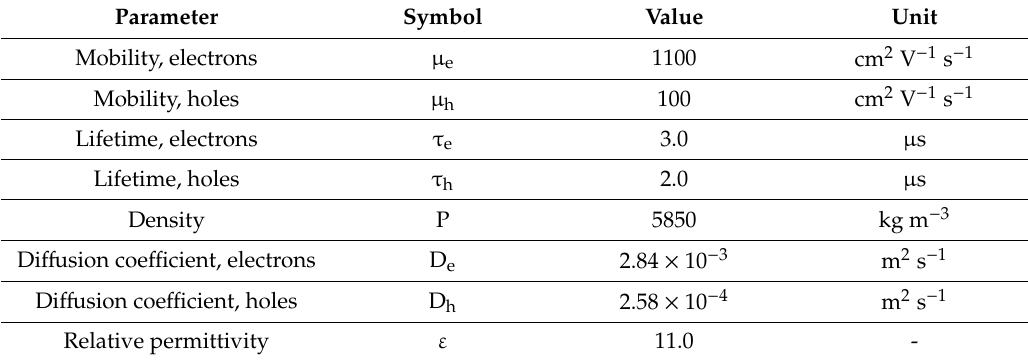
Table 1. CdTe material properties used for finite element